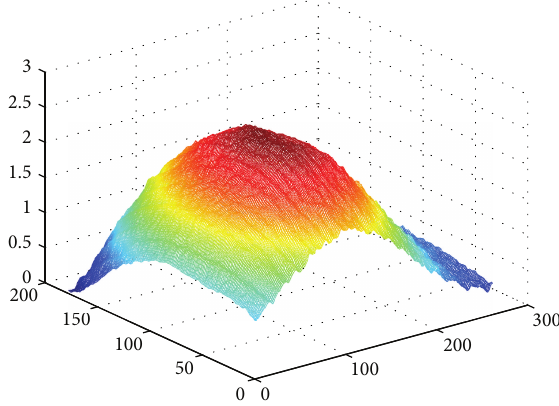
Figure 28: Difference in inflammation between the three-dimen- sional reconstruction of the reference and the maximum inflamma-